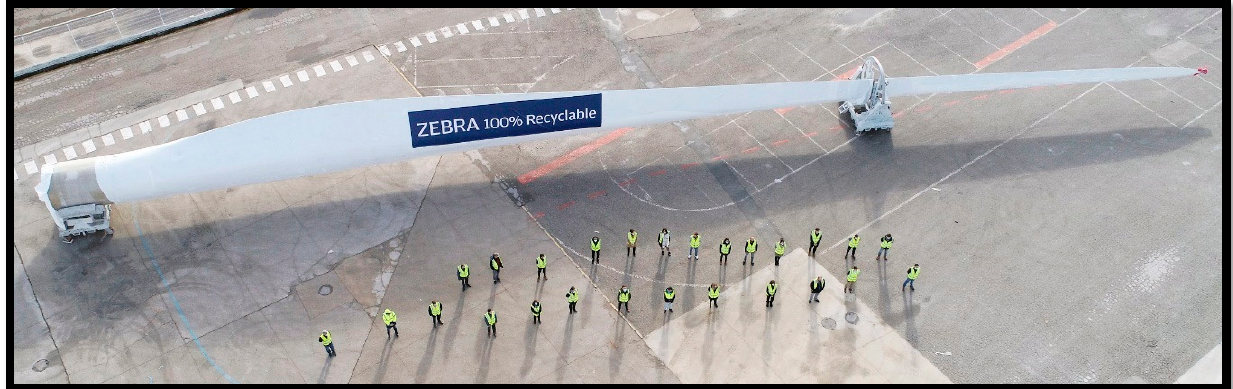
Figure 1. Zebra 100% recyclable wind turbine blade [31].